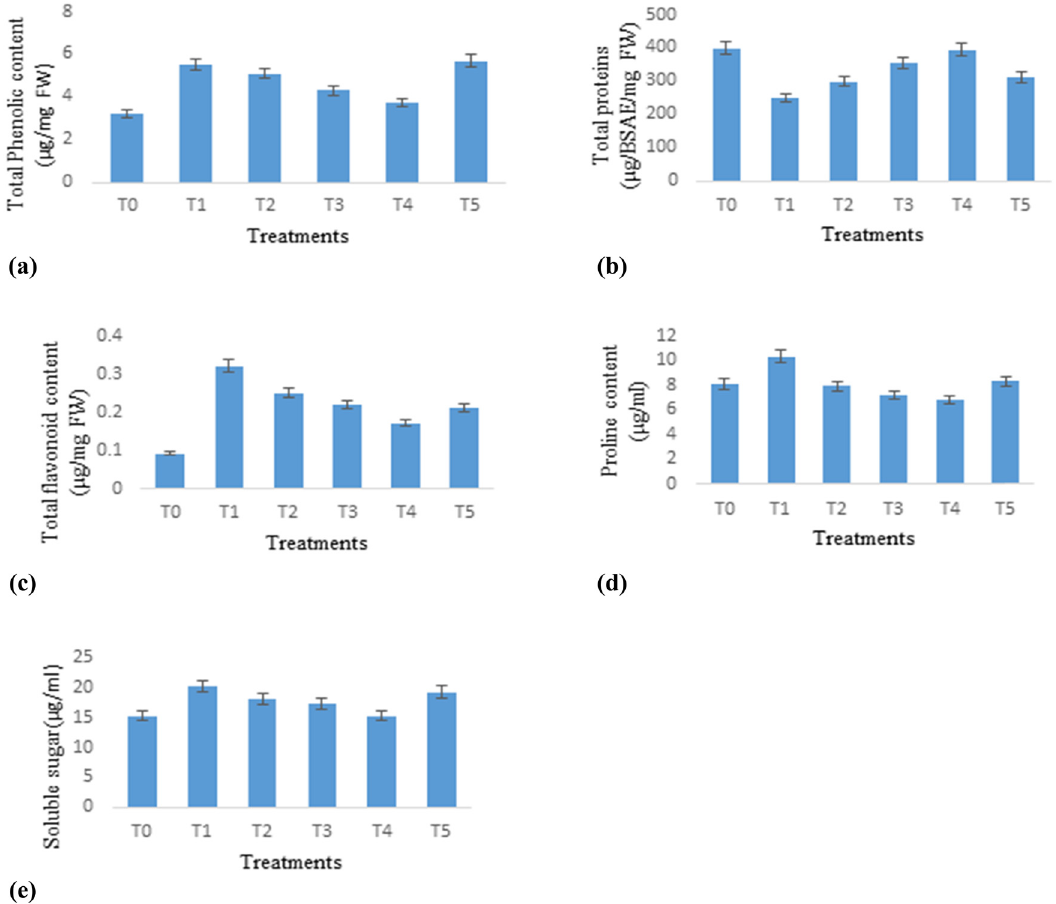
Figure 11: Nonenzymatic attributes: ( a ) TPC, ( b ) total proteins, ( c ) TFC, ( d ) proline content, and ( e ) soluble sugar of wheat plants under P. striiformis stress in response to various concentrations of AgNPs: 25, 50, 75, and 100 mg · L − 1 . The data is presented as the mean ± S.D from three independent biological replicates. The error term is mean square error = p ≤